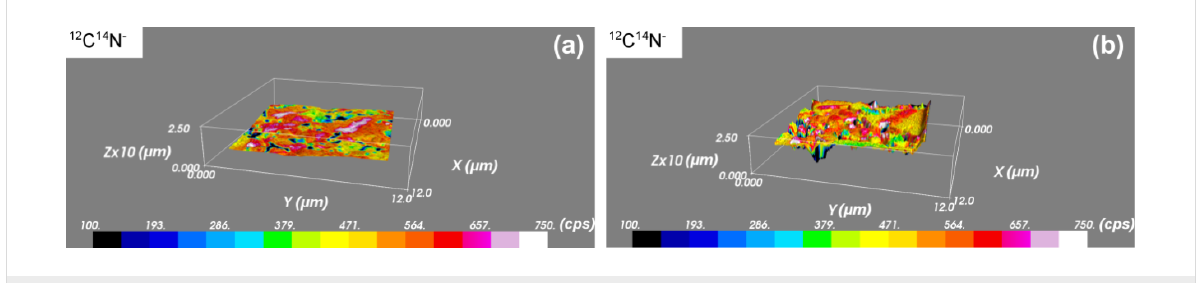
Figure 3: Snapshot of SIMS-SPM reconstructed surface before (a) and during (b) SIMS analysis performed on Ti(C,N). The colour scale represents the 12 C 14 N − secondary ion intensity recorded by SIMS. The carbon containing phase sputters more slowly than the phase comprising the Co